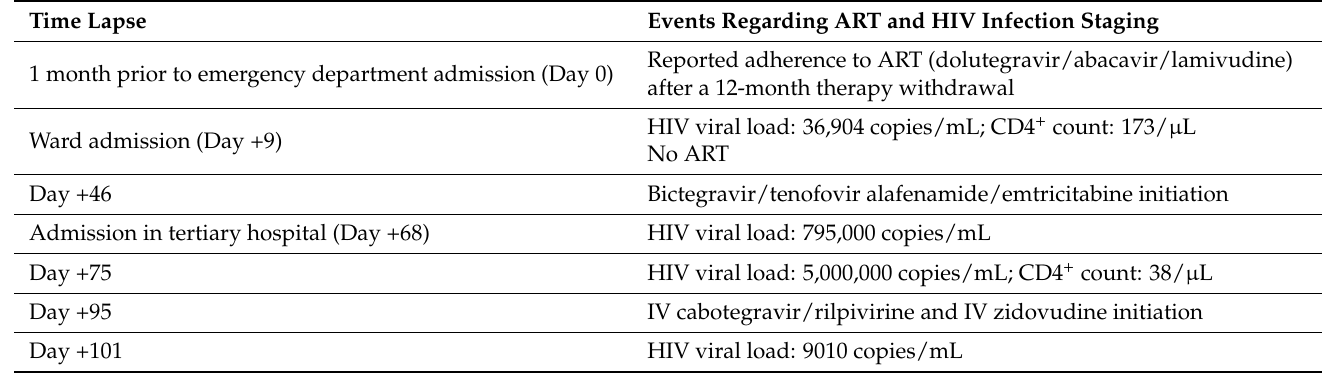
Figure 3. Abdominopelvic CT scan on day +73 with marked thickening of jejuno-ileum and colon mucosa, suggesting enterocolitis. Table 1. Timeline of main events regarding ART modification of initiation and HIV